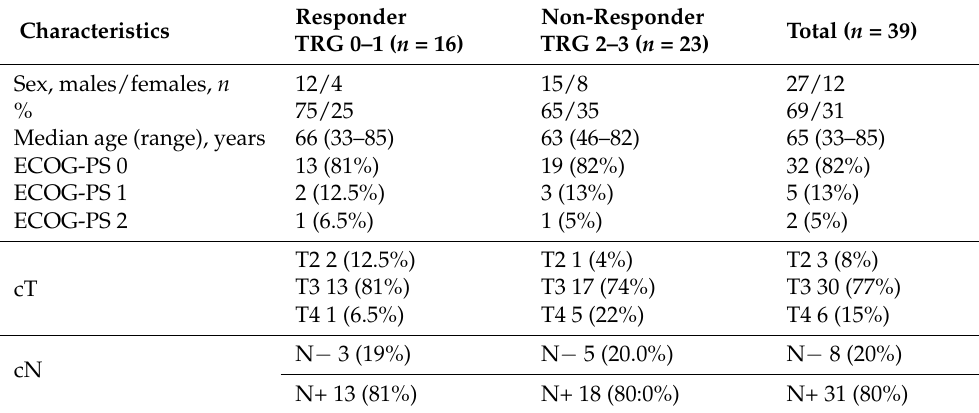
Table 1. Baseline characteristics of the patients included in the analysis after receiving the same neoadjuvant chemoradiotherapy regimen. Abbreviations: ECOG-PS: “Eastern Cooperative Oncology Group performance status”; TRG: tumor regression grade; cT and cN: “clinical tumor stage” and “clinical node stage”, respectively, according to the TNM staging of rectal